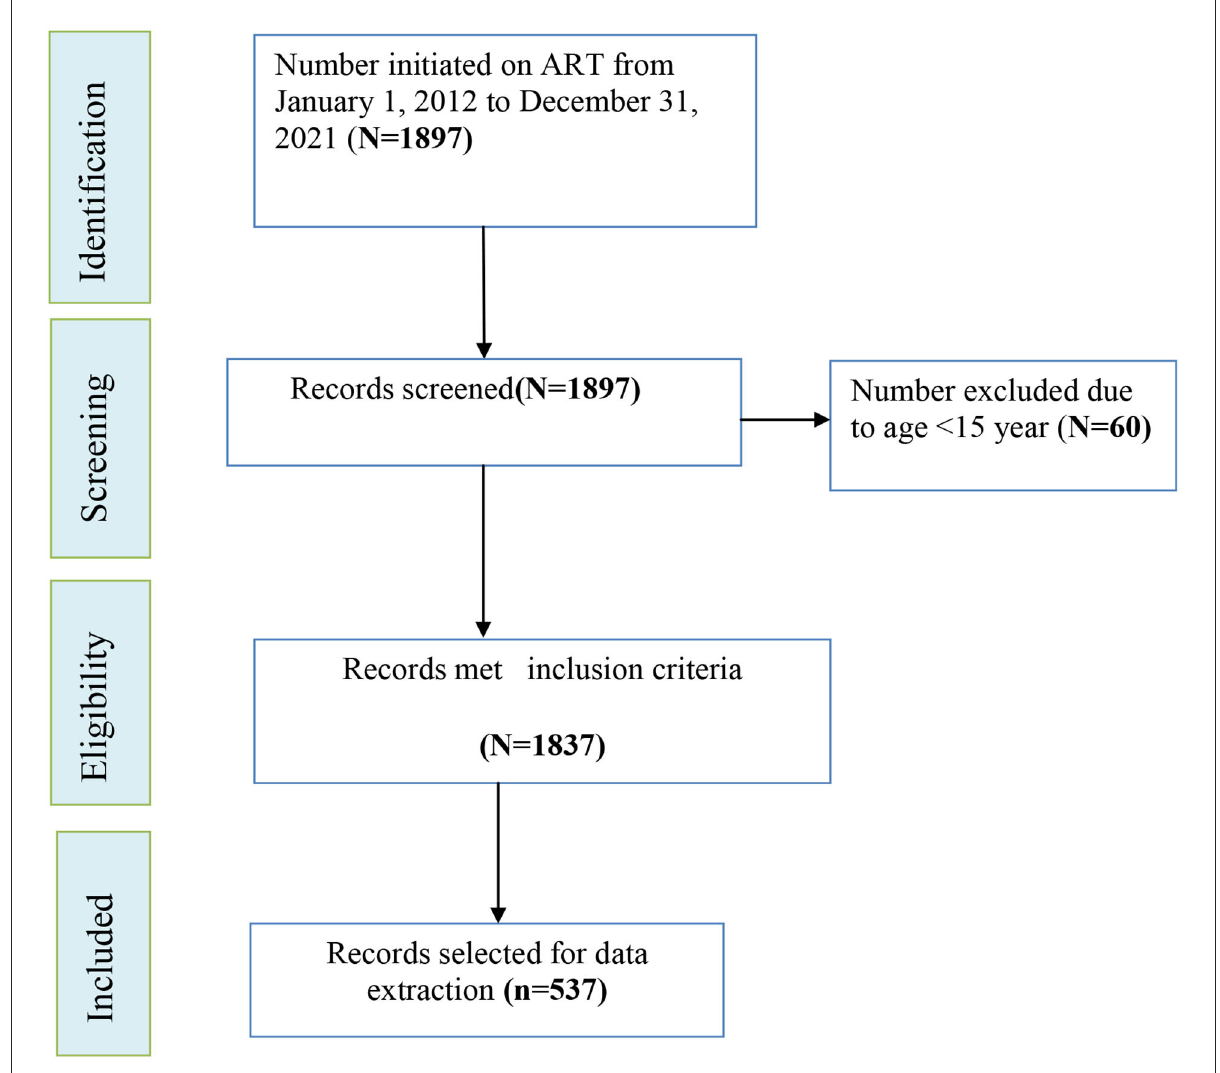
FIGURE1 Schematic illustration of sampling procedure for incidence and predictors of OIs among adolescents and adults after the initiation of ART at WSUCSH, Southern Ethiopia,